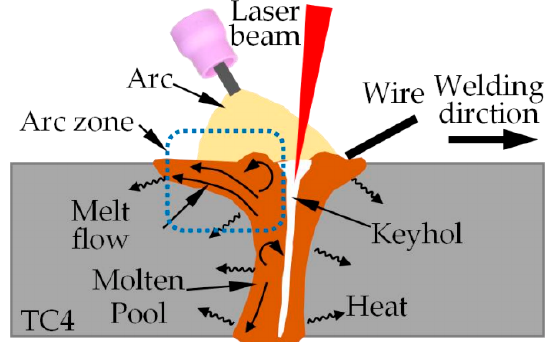
Figure 20. Schematic diagram of molten pool flow in arc zone.